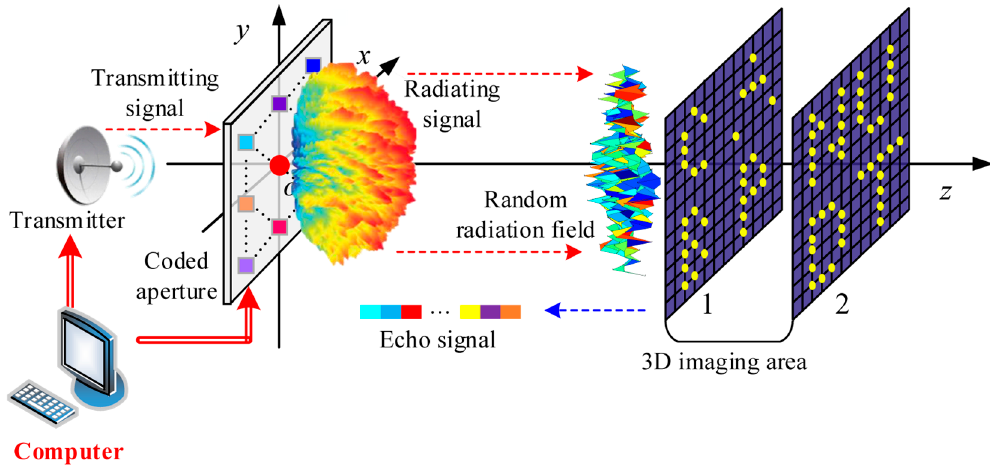
Figure 1. Schematic diagram of traditional 3D TCAI architecture.